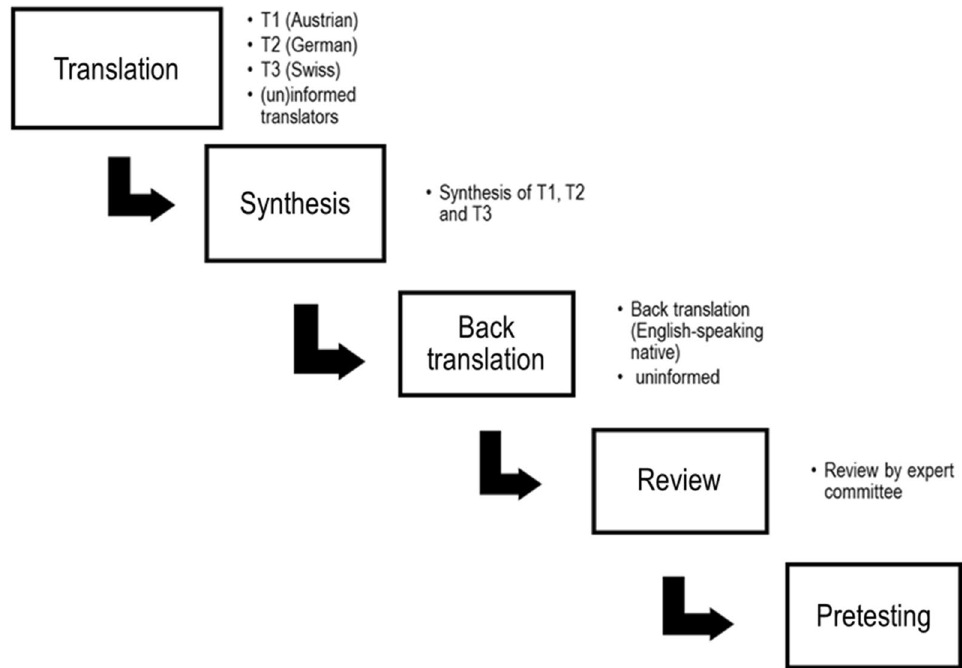
Fig. 1 Flowchart illustrating the translation and validation